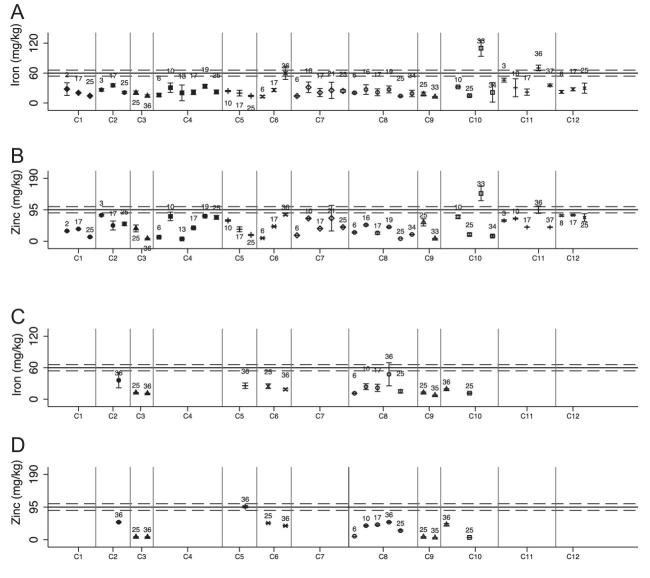
Total mean iron and zinc content of composite samples of wheat flour brands collected from markets and household, measured in triplicate. Error bars = 1 SD (accounting for analytical error). Vertical gray bars separate the clusters. Number labels reflect the brands. Horizontal gray reference lines represent the lower and upper acceptable thresholds, and the black line represents the national fortification standard. (A) Total iron concentration of wheat flour samples collected at market sites. (B) Total zinc concentration of wheat flour samples collected at market sites. (C) Iron concentration of wheat flour samples collected at household sites. (D) Zinc concentration of wheat flour samples collected at household sites.